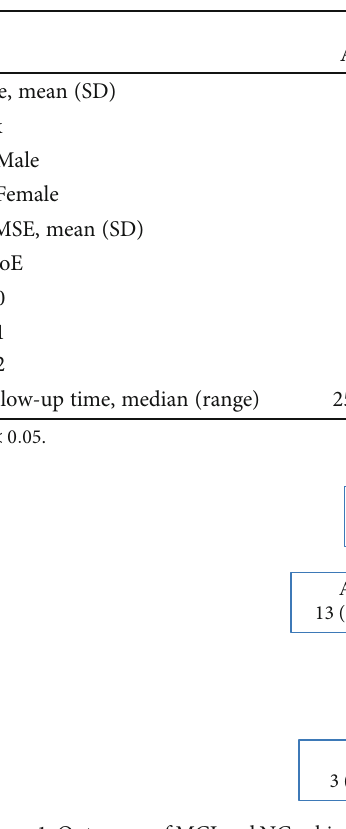
Table 1: Baseline characteristics of subjects with brain PET Abeta.